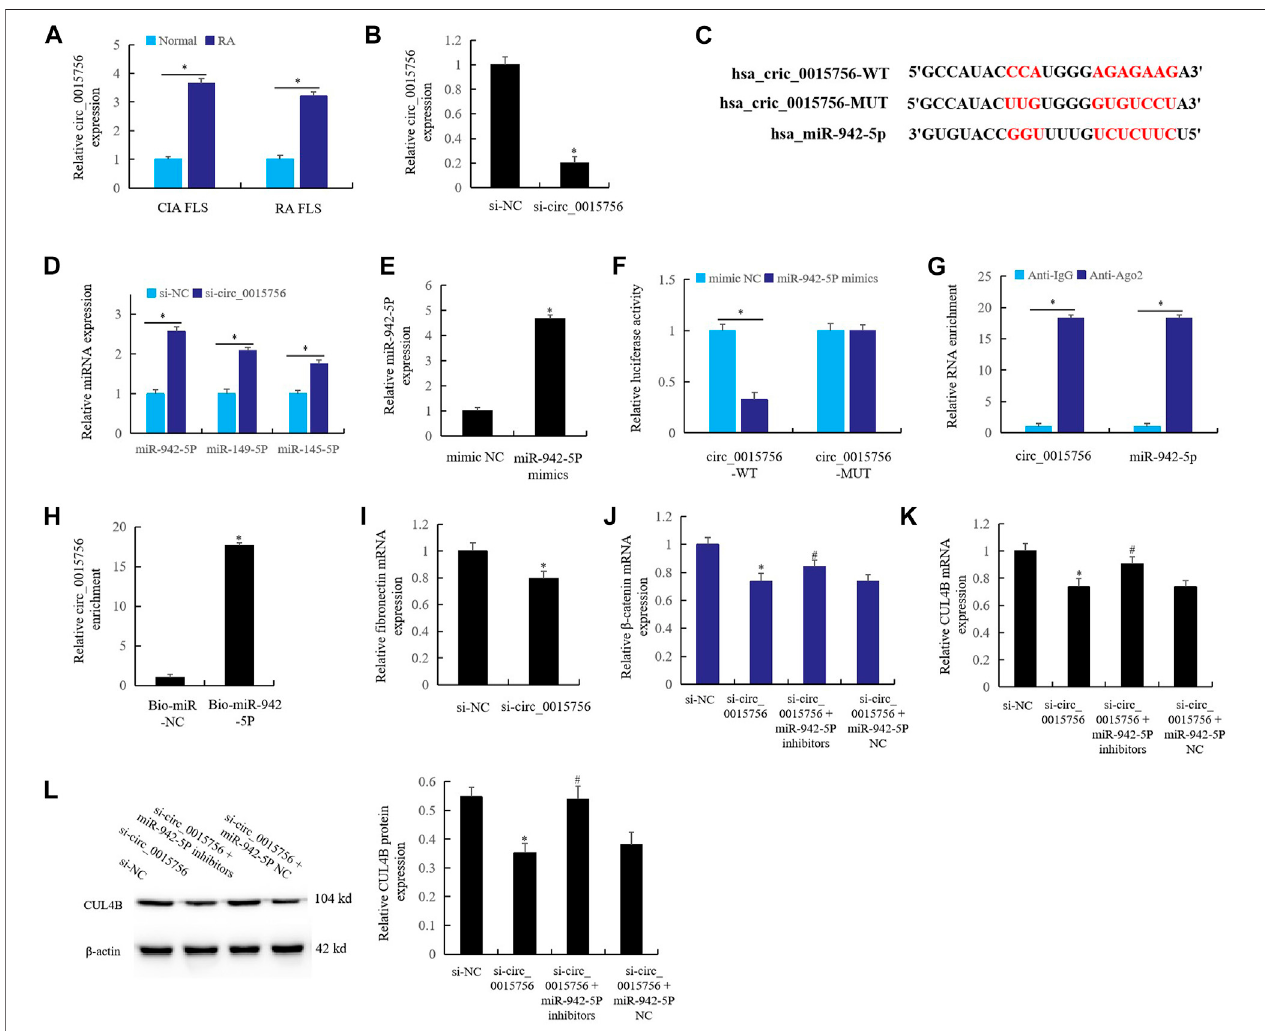
FIGURE 6 | Effect of circ_0015756 on the miR-942-5p in RA FLS. (A) the expression of circ_0015756 in RA synovium and FLS; (B) : the expression of circ_0015756 decreased after knockout of circ_0015756; (C) : bioinformatics prediction; (D) : circ_0015756 knockout up-regulate the expression of miR-942-5p; (E) : the role of miR-942-5p mimics in the expression of miR-942-5p was detected by real-time qPCR; the direct interaction between circ_0015756 and miR-942-5p was detected by double luciferase reporter gene (F) , RIP assay (G) and RNA pull-down assay (H) ; (I) : the effect of knockout of circ_0015756 on the fi bronectin was detectedbyreal-timeqPCR; (J – L) :theeffectsofmiR-942-5psilencingonthecirc_0015756knockoutweredetectedbyreal-timeqPCRandwesternblotting.For (J – L) , *Si-circ_0015756 group was compared with si-NC group; #si-circ_0015756+miR-942-5p inhibitor group was compared with si-circ_0015756 group.